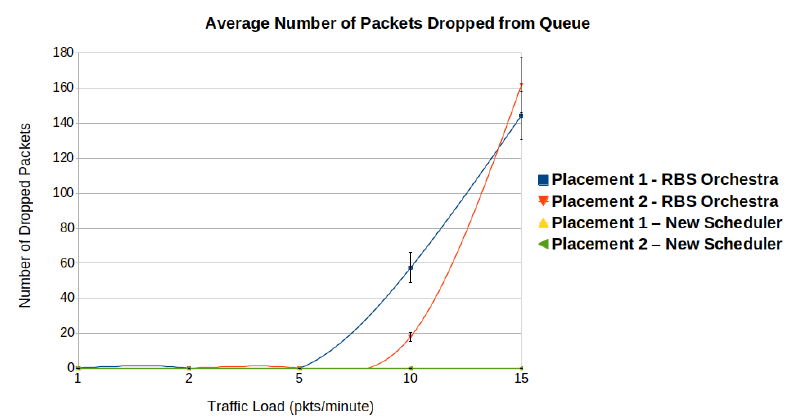
Figure 10. We observe that when it comes to average number of packets dropped from queues, the new scheduler performs better than Orchestra, in high traffic situation.